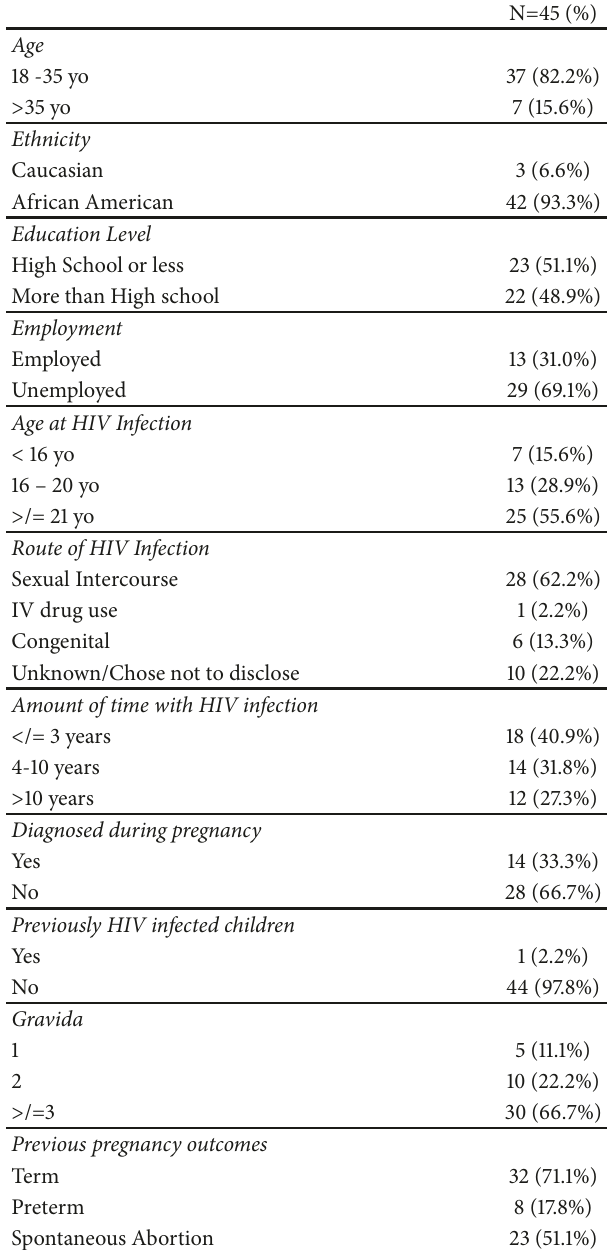
Table 1: Demographics of cohort of HIV infected pregnant women. Table 2: Medication adherence during pregnancy in cohort of HIV infected women